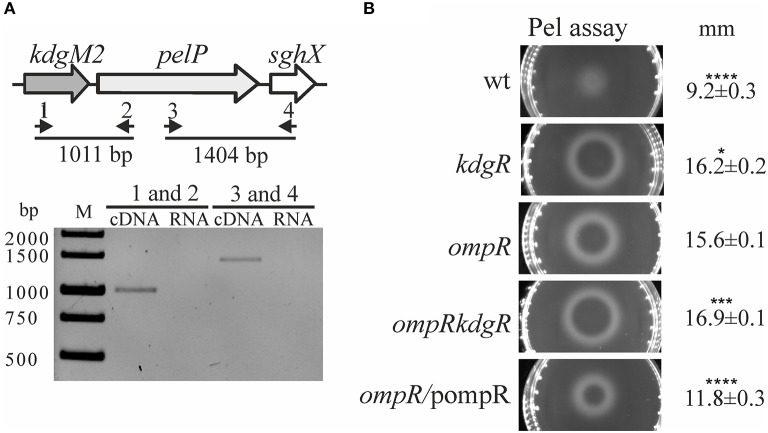
Effect of OmpR and KdgR on pectate lyase (PelP) production. (A) To determine whether the kdgM2, pelP, and sghX genes are organized in an operon, two pairs of primers were used in RT-PCR analysis (1–RTkdgMpelP1/2–RTkdgMpelP2 and 3–RTpelPsghX1/4–RTpelPsghX2) (A, upper panel). RT-PCR analysis of the kdgM2-pelP-sghX operon (A, lower panel). Total RNA isolated from strain Ye9 grown in LB medium at 26°C was DNase treated and then reverse transcribed into cDNA with pairs of primers shown in (A) upper panel. M – molecular size marker GeneRuler 1 kb DNA Ladder; bp. RNA was used as the template in negative control reactions. (B) Changes in pectate lyase (PelP) production in the tested Y. enterocolitica mutants lacking OmpR, KdgR or both regulatory proteins. Periplasmic PelP activity was determined in a semi-quantitative manner by measuring the diameter of haloes on plates containing OGAs and Ca2+, 48 h after inoculation with osmotic shock fluid obtained from exponential phase Y. enterocolitica cultures grown in LB medium at 26°C. PelP production was compared in the following strains: Ye9 (wild-type), ES1 (kdgR mutant), AR4 (ompR mutant), AR11 (ompRkdgR mutant), and complemented AR4 (ompR/pompR). The data represent mean values with standard deviations, obtained in at least three independent experiments. Significance was calculated using one-way ANOVA (*P < 0.05, ***P < 0.001, ****P < 0.0001). P-values were calculated using (assuming unequal variances) comparing test strains to the AR4 strain.